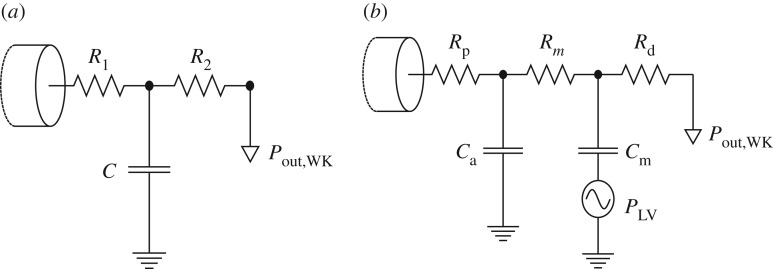
Schematic of the two lumped parameter models used in this work, WK3 model (a) and WKcor (b). R1, R2, Rp, Rm and Rd are resistance parameters, C, Ca and Cm are compliance parameters and PLV and Pout,WK are left ventricle and outflow windkessel pressures, respectively.